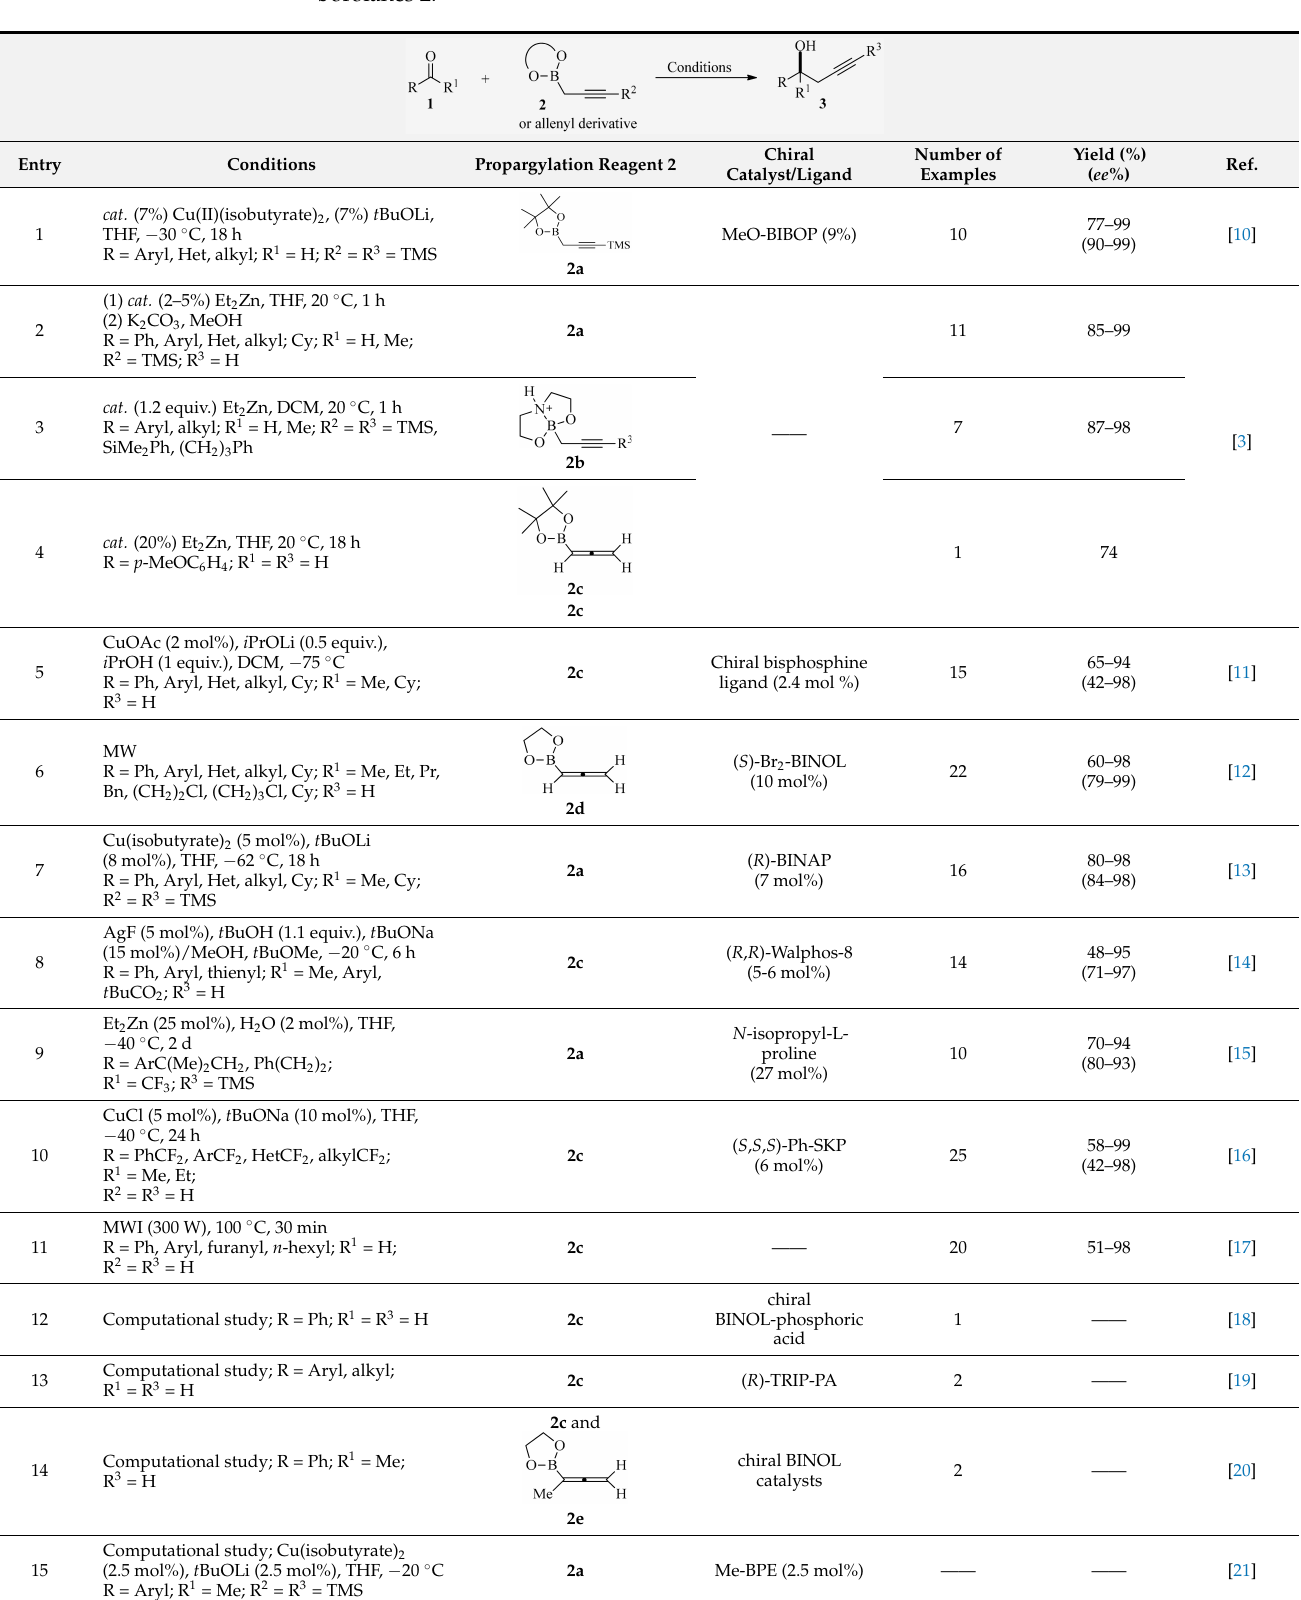
Table 2. Propargylation of diversely substituted aldehydes/ketones 1 with